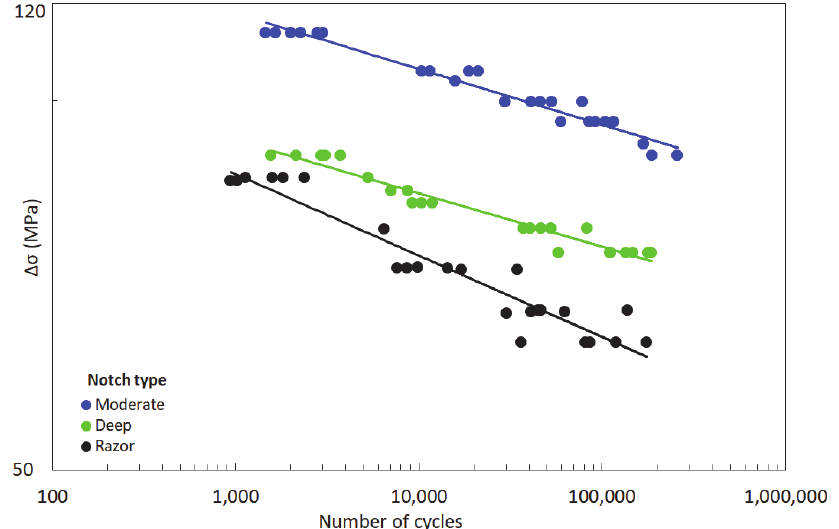
Figure 2: Experimental S-N curves for the three different notched geometries, i.e. moderate (U-notched with a notch radius of 0.9 mm), deep (U-notched with a notch radius of 0.45 mm) and razor (circumferentially cracked). Modified from Sobieraj et al. [61].